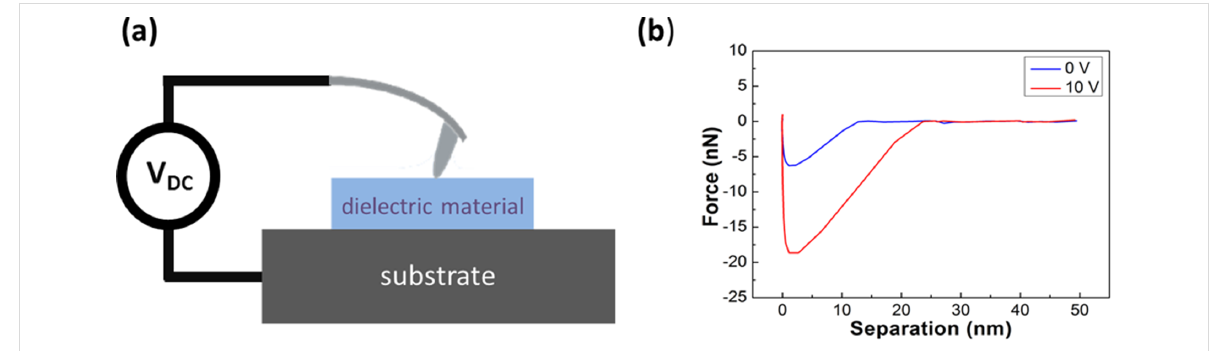
Figure 1: Schematic representation of the experimental principle. (a) A dc voltage can be applied to the AFM tip in PF-QNM mode under ambient conditions. (b) Representative retracting lines of force–distance curves under tip biases of 0 V and 10 V. The adhesion force between the tip and the sample will increase due to polarization of the sample when the tip is biased at 10